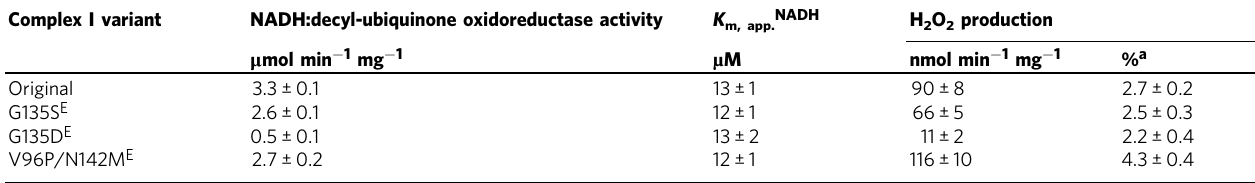
a Percentage of the NADH:decyl-ubiquinone oxidoreductase activity The activities were measured in 50mM NaCl, 50mM MES/NaOH, pH 6.0. The initial NADH:decyl-ubiquinone oxidoreductase activity was determined using 5 µ g of protein, 60 µ M decyl-ubiquinone, and 150 µ M NADH. H 2 O 2 production was measured with the Amplex-red assay using 2U ml − 1 horseradish peroxidase, 10 µ M Amplex-red, and 30 µ M NADH. Background rates in the presence of catalase were subtracted. The change in absorbance at 557 – 620nm was recorded. Assay conditions: 5 µ g of protein, in 1ml (total volume) 50mM MES/NaOH, 50mM NaCl, 0.1% (w/v) dodecyl- maltoside, pH 6.0. The values were derived from three independent measurements